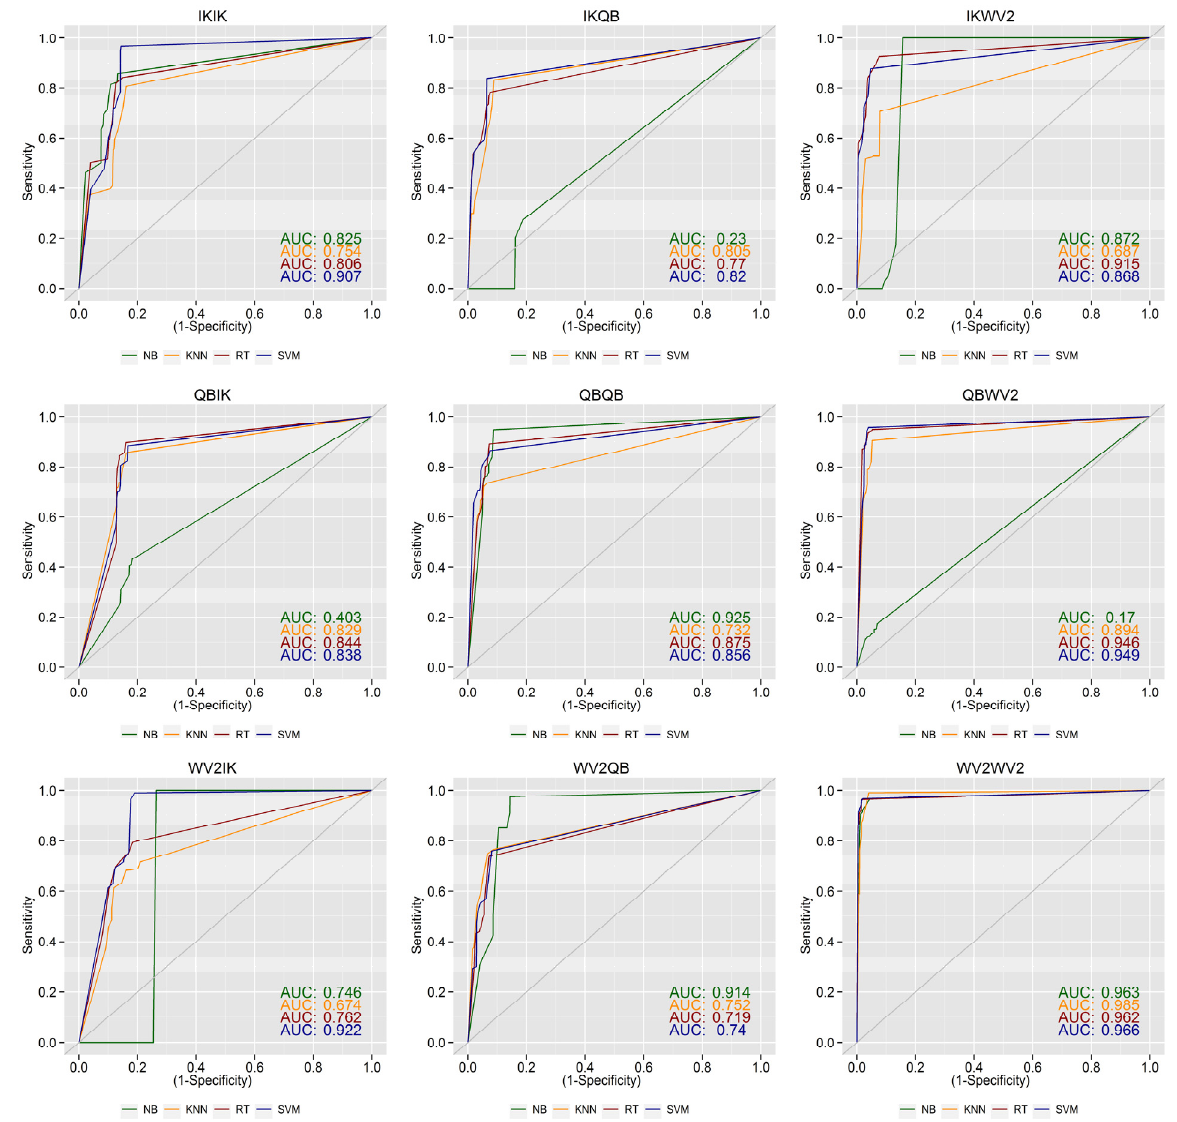
Figure 11. Classifier performance for different training-testing scenarios on VHR image